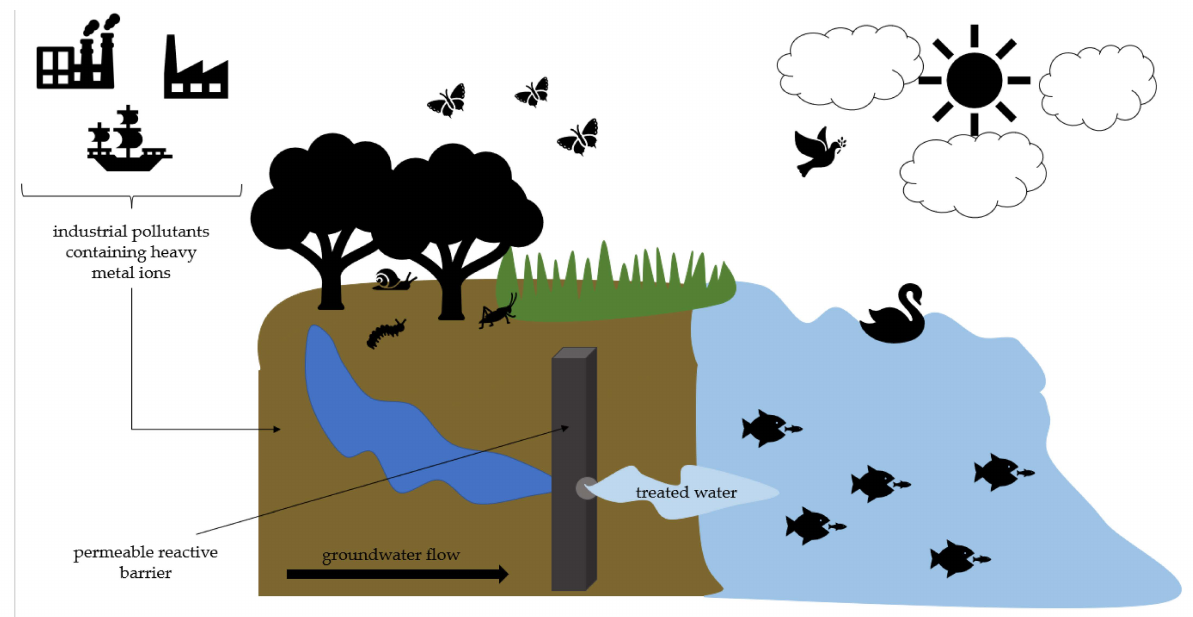
Figure 1. The mechanism of action of a permeable reactive barrier. Source: own graph based on Moore et al., 2016